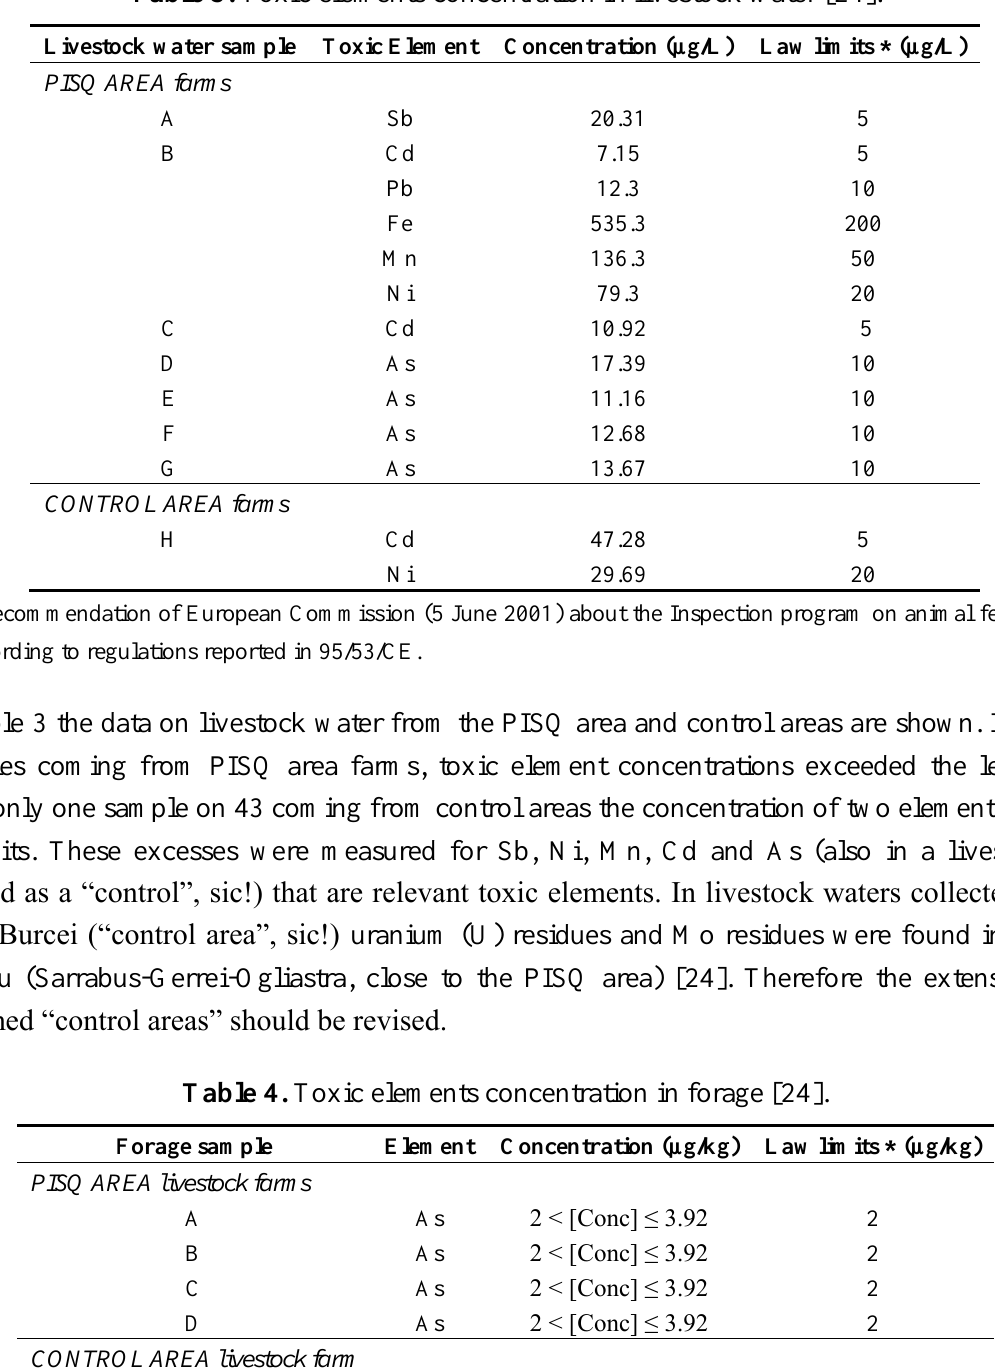
Table 3. Toxic elements concentration in livestock water [24].